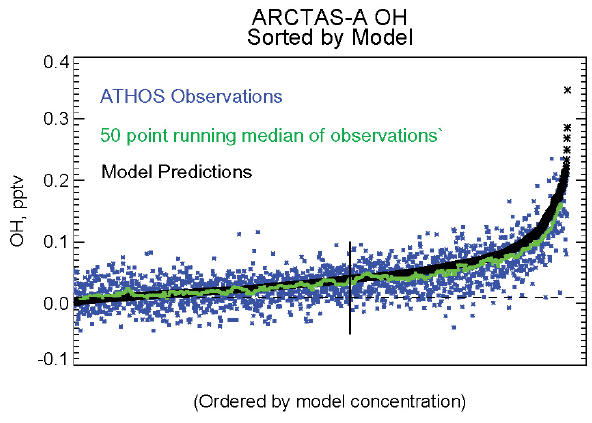
Fig. 10. Observed (blue) and model-predicted (black) concentra- tion pairs of OH during ARCTAS-A sorted by increasing model concentration. The green line shows a 50 point running median of observations along the sorted